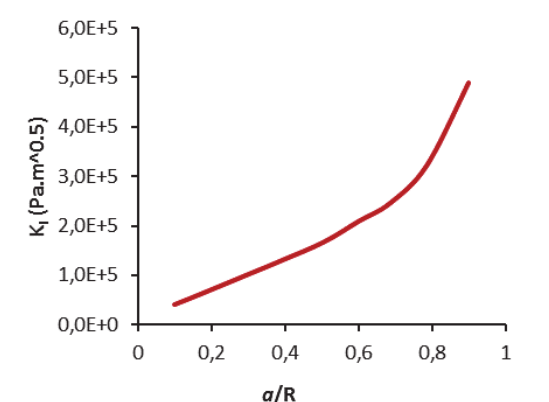
Figure 4: Stress intensity factor versus ratio of crack radius to cylinder